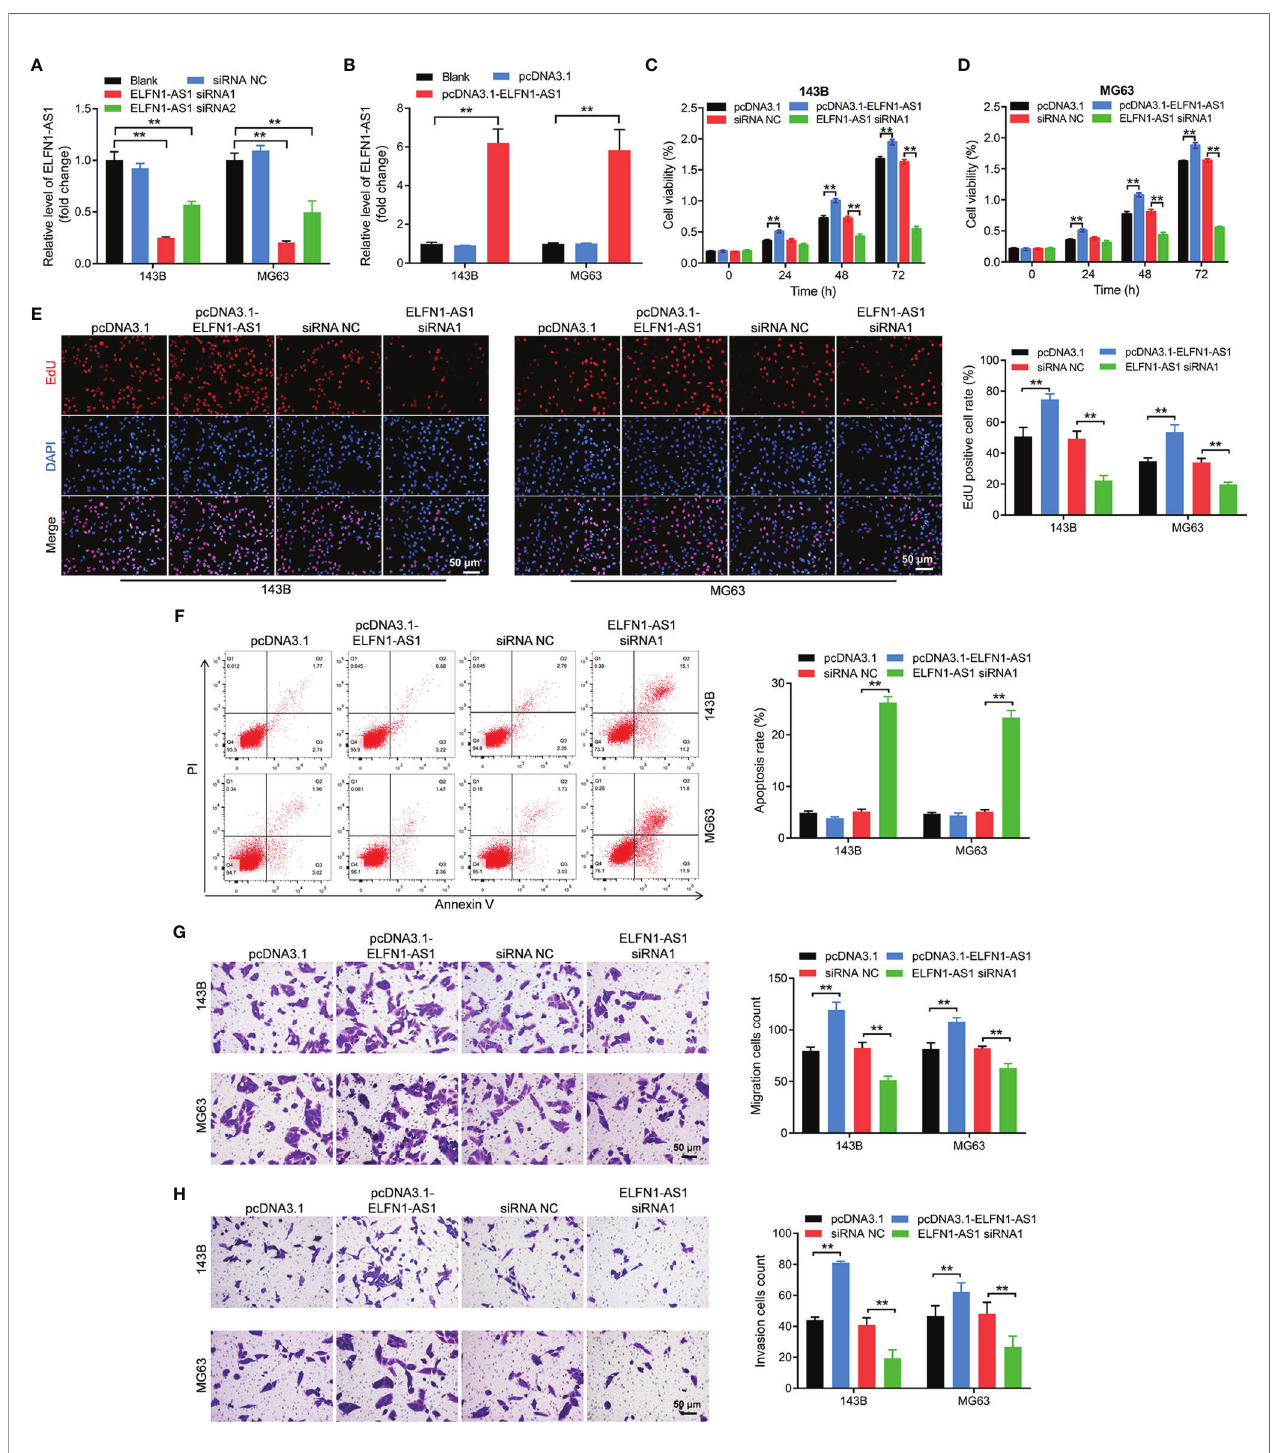
FIGURE 2 | ELFN1-AS1 promoted the proliferation, migration and invasion of OS cells. (A) RT-qPCR analysis of ELFN1-AS1 level in 143B and MG63 cells transfected with ELFN1-AS1 siRNA1 or ELFN1-AS1 siRNA2 (n = 3). (B) RT-qPCR analysis of ELFN1-AS1 level in 143B and MG63 cells transfected with pcDNA3.1 ELFN1-AS1 (n = 3). (C, D) 143B and MG63 cells were transfected with pcDNA3.1 ELFN1-AS1 or ELFN1-AS1 siRNA1. CCK-8 assay was applied to measure cell viability (n = 3). (E) EdU staining assay was applied to detect cell proliferation (n = 3). (F) Flow cytometry assay was applied to determine cell apoptosis. (G) Transwell migration and (H) invasion assays were applied to determine cell migration and invasion (n = 3). The signi fi cance between groups was analyzed by one-way ANOVA. **P <